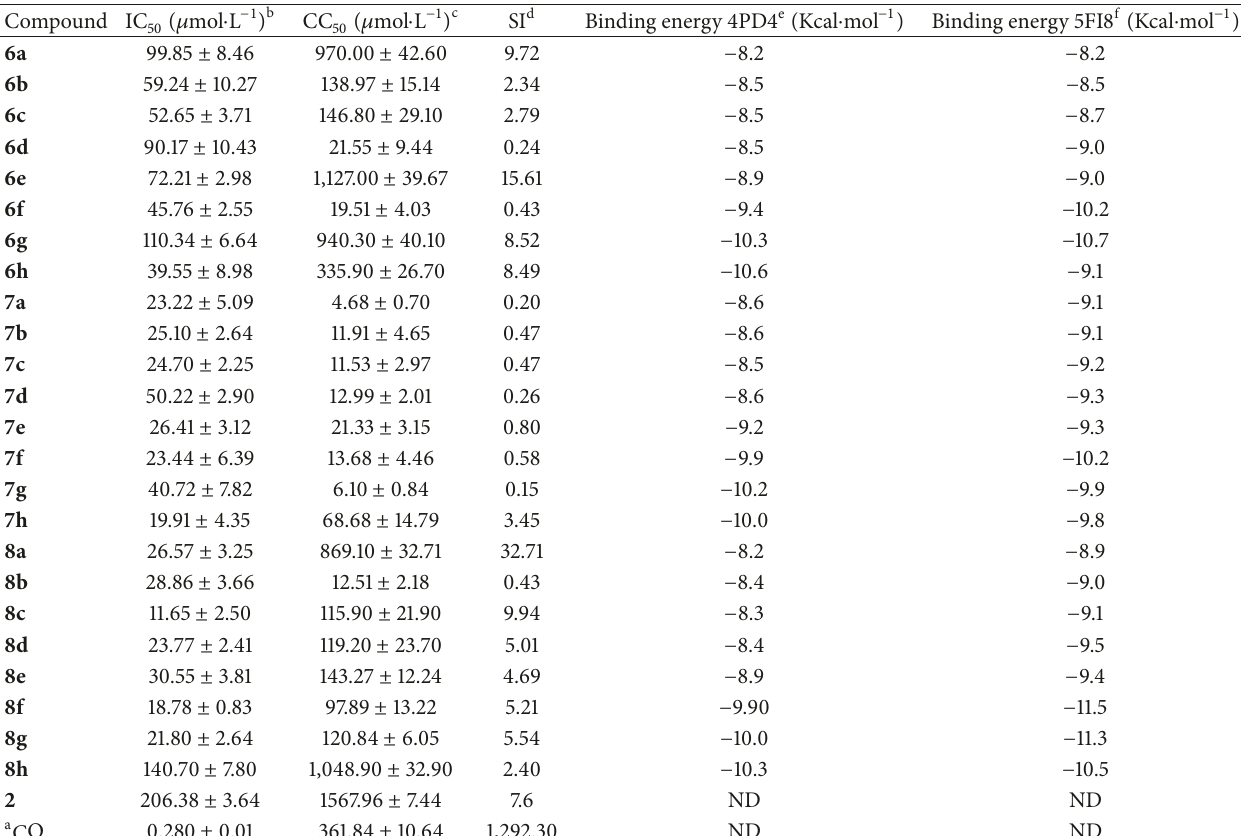
Table 2: In vitro antiplasmodial activity (IC 50 ) against Plasmodium falciparum (W2), cytotoxicity (CC 50 , Hep G2A16 cells), selectivity index (SI), and binding energy values of docking simulations for 4PD4 and 5FI8 with naphthoquinones 6a–h , 7a–h , and 8a–h